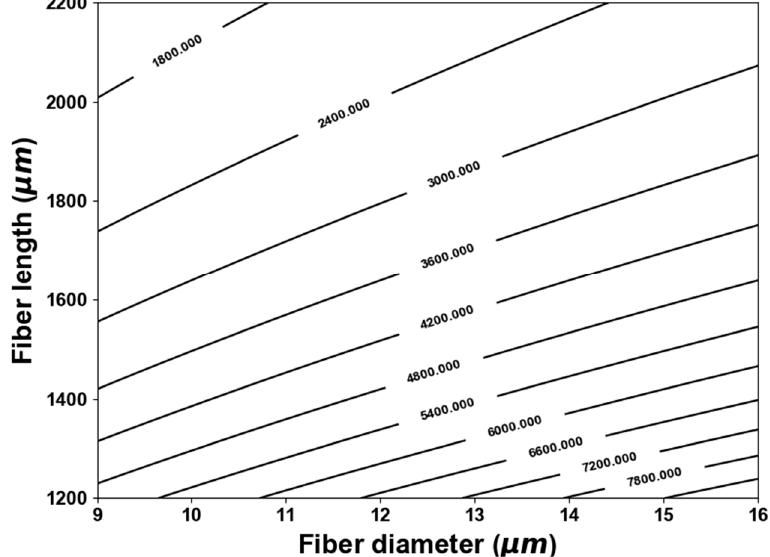
Figure 2. Damped natural frequency of the system (in Hz) as a function of micro-cantilever length and diameter.